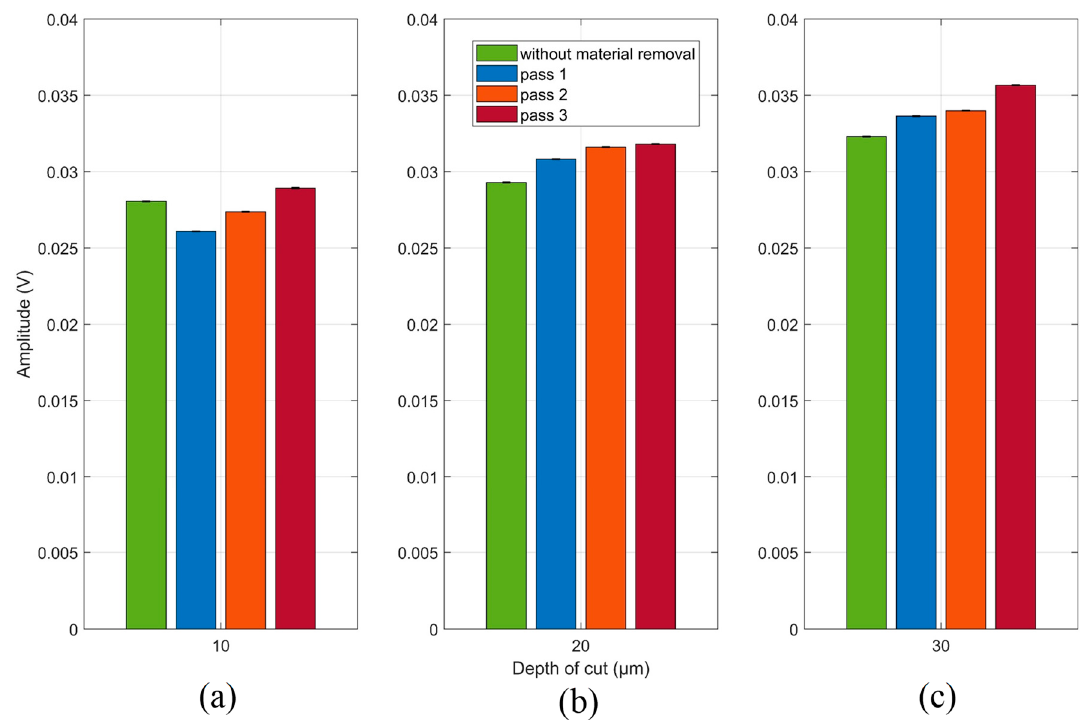
Figure 8. RMS mean and standard deviation values of the raw unfiltered signals at ( a ) 10 µ m, ( b ) 20 µ m and ( c ) 30 µ m.